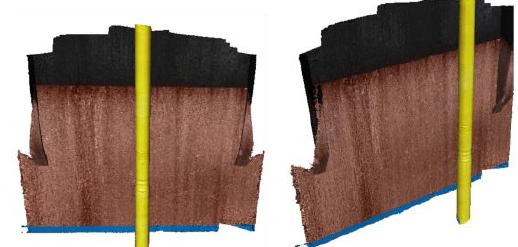
Figure 12. Photogrammetric 3D dense cloud for the virtual images acquired with DJI Z30 camera parameters.